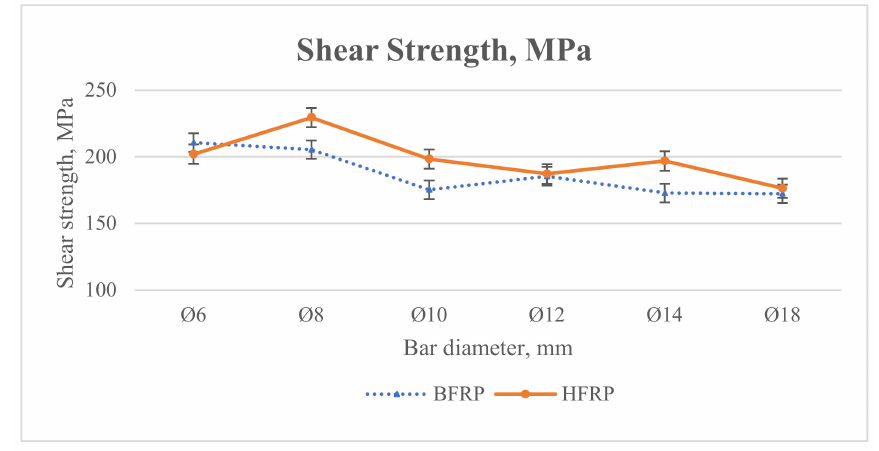
Figure 8. Comparison of average shear strength testing results of di ff erent FRP bars for all